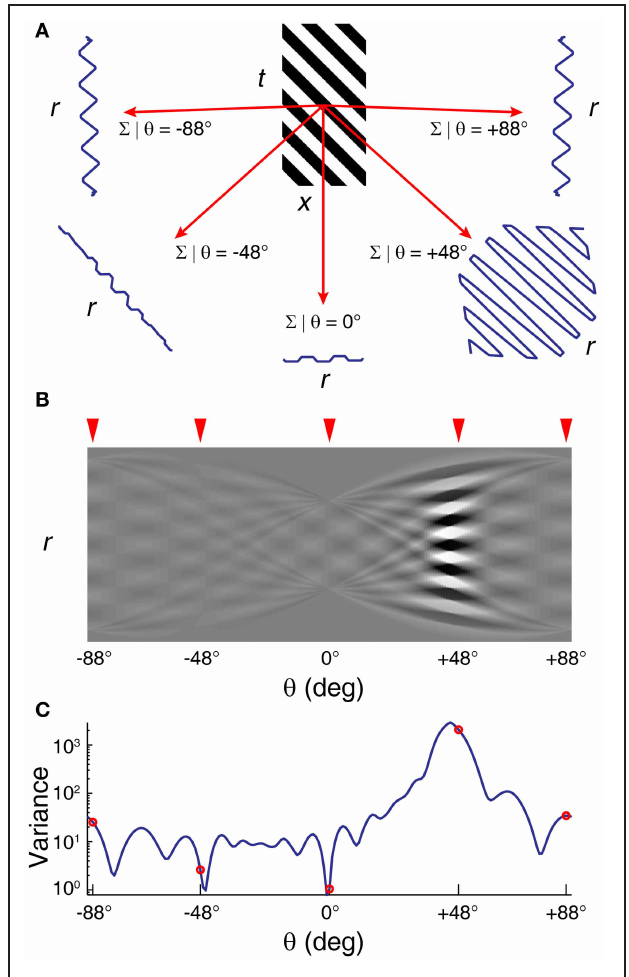
FIGURE 4 | Radon transform of a striped image F ( x,t ) using 1 ◦ step-size. (A) Sample Radon transforms at 5 example angles. (B) Radon transform space ˜ F ( r , θ ) and (C) variance at each angle spaced at 1 ◦ . Radon transforms at 5 selected angles in (A) are indicated by the red arrowheads on the Radon transform space in (B) and as red open circles on the variance plot in (C) . Peak in the variance at + 45 ◦ signify the stripe angle of + 45 ◦